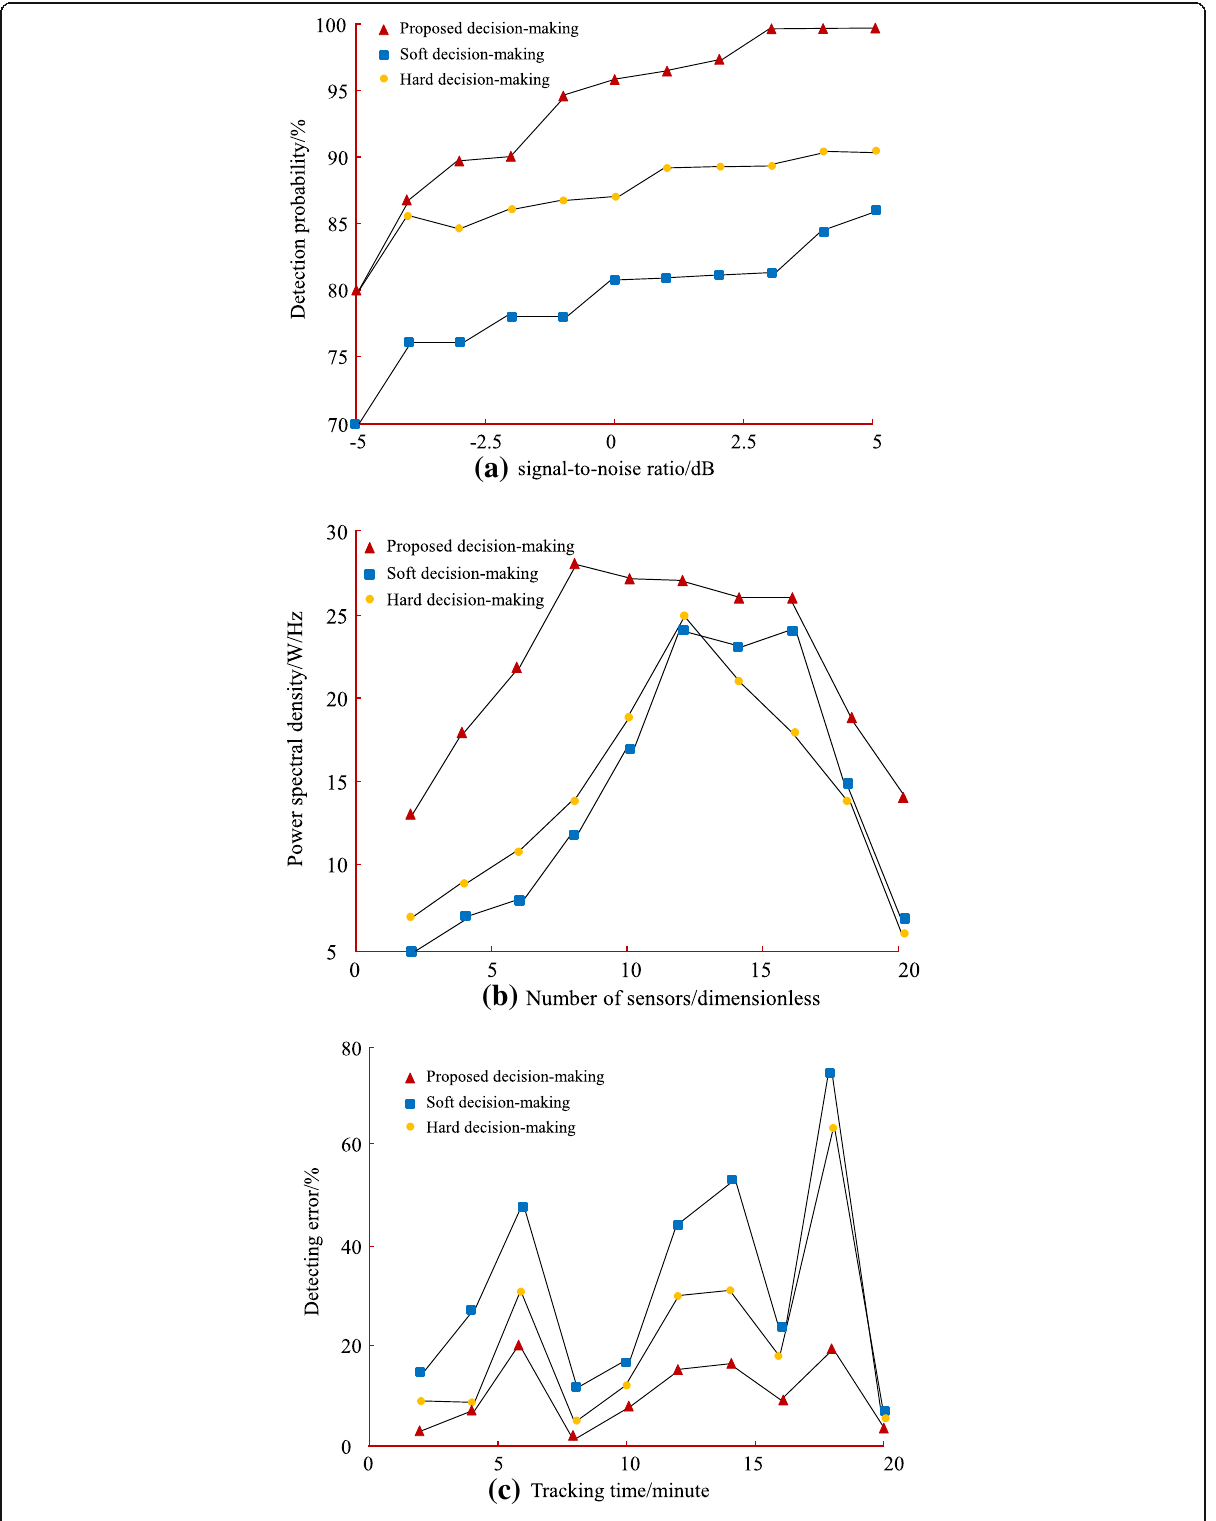
Fig. 9 a Detection accuracy with clutter. b PSD for fixed frequency and different sensor number. c Detection error for different tracking